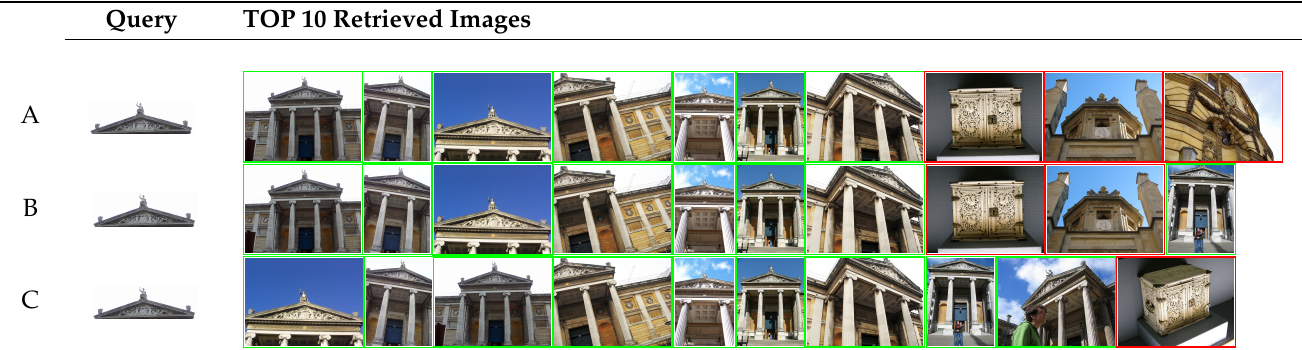
Table 5. Image retrieval comparison of PCAw, SPCA, and G-CCA.